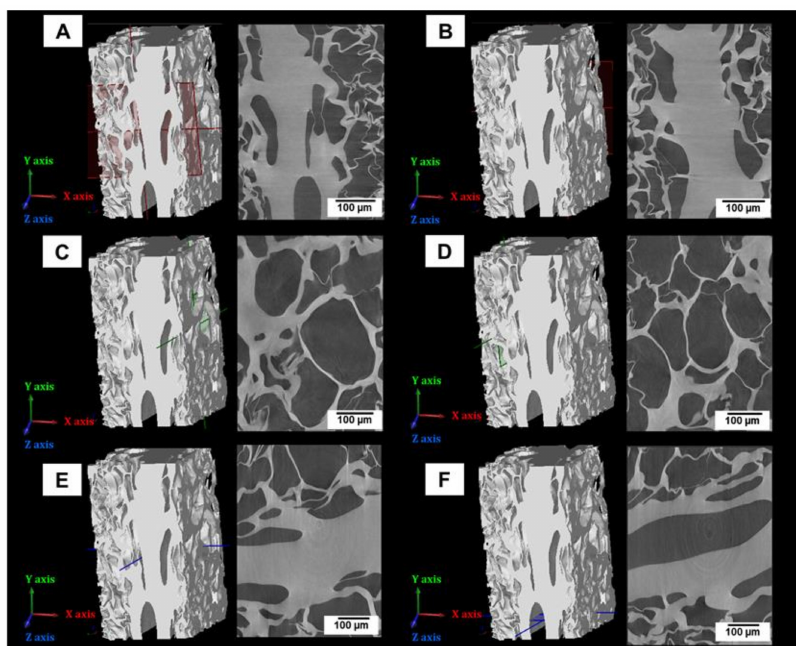
Figure 6. Representative images of orthogonal planes of the lyophilized PVP hydrogel obtained by nano-CT. The images (right side) were acquired in orthogonal planes of the virtual reconstruction (left side): ( A , B ) XY-plain in red colour, ( C , D ) YZ plain in green colour and ( E , F ) XZ-plain in blue colour.